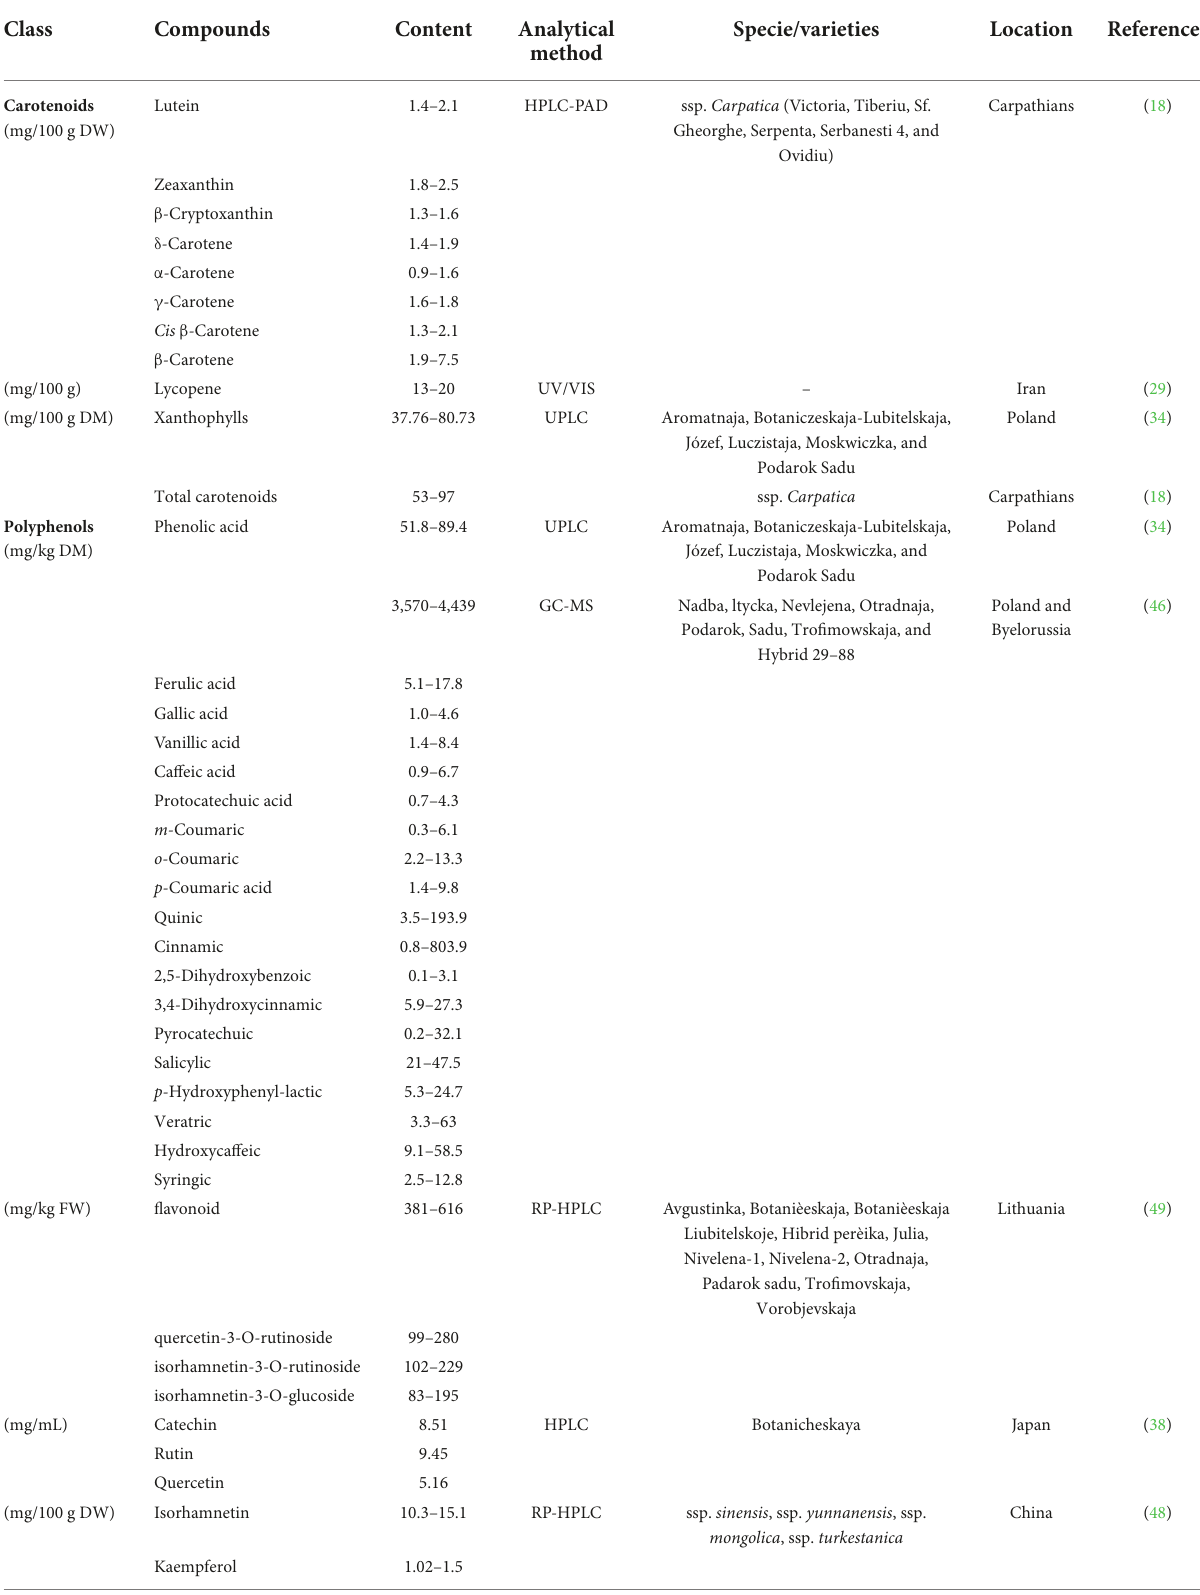
TABLE 3 Main bioactive components in sea buckthorn